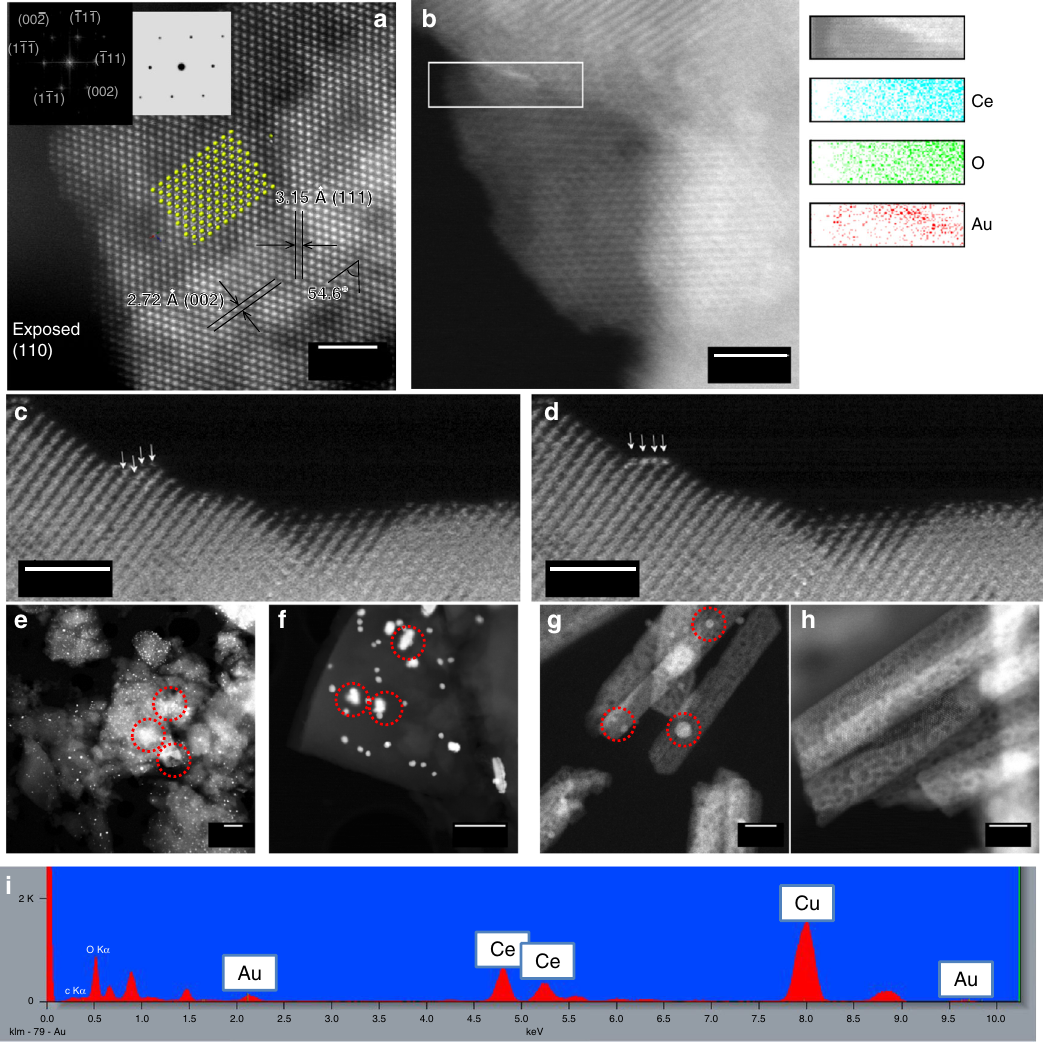
Fig. 2 HAADF-STEM imagings and spectroscopy of the Au/CeO 2 and Au/AC. a Lattice structure of an Au/CeO 2 nanorod and annotated model structure of the CeO 2 (110) exposed plane (yellow ball = Ce atom, light grey ball = O atom) (scale bar, 2.5 nm). Inserts are the FFT pattern and corresponding simulated FFT pattern. (also see Supplementary Figure 5) b Elemental EDS mapping, from the area marked within a white box, of an Au/CeO 2 nanorod (scale bar, 2.5 nm). c A snapshot image of Au atoms dispersed on CeO 2 and d their drift to the edge of CeO 2 under electron beam (scale bar, 1 nm). e , f The Au/AC pre-reduced in 5% H 2 /N 2 for 3 h and reactivated under HCl/C 2 H 2 after 5 h (scale bar, 0.5 μ m). g , h The Au/CeO 2 pre-reduced in H 2 for 3 h and reactivated under HCl/C 2 H 2 after 5 h (scale bar, 10 nm). (Au particles in red cycles) i EDS of an Au/CeO 2